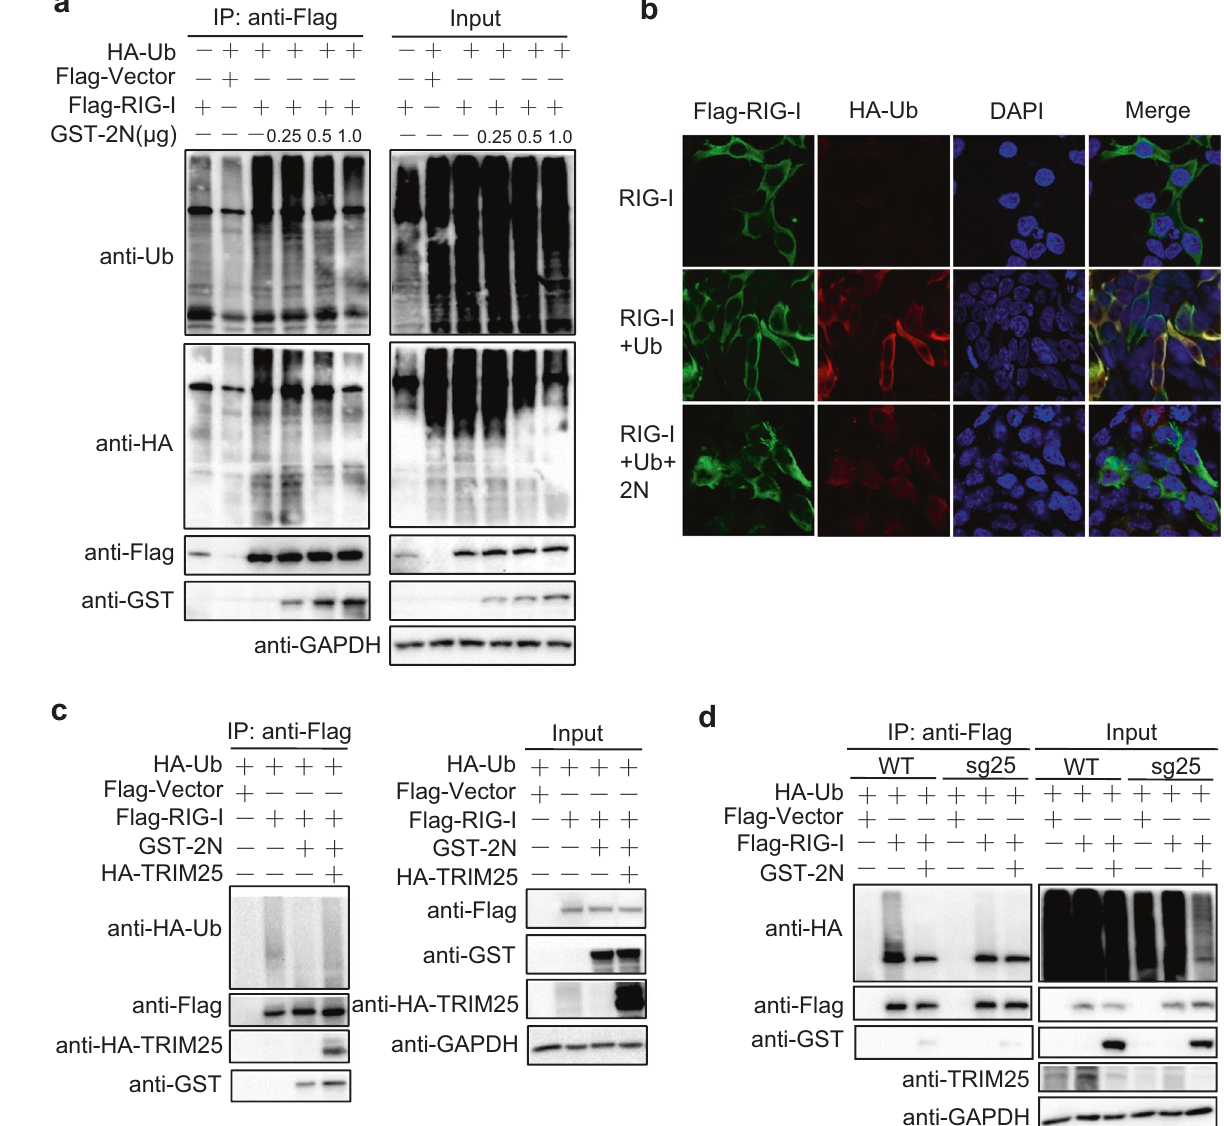
Fig. 6 2N protein inhibits RIG-I ubiquitination through TRIM25. a HEK293T cells in six-well plate were transfected with HA-Ub and Flag-RIG-I plasmids as indicated, together with an increasing GST-SARS-CoV-2 N (GST-2N) plasmid. At 24 hpt, anti-Flag immunoprecipitates were analyzed by immunoblot with anti-Ub, HA, Flag, and GST antibodies. b HEK293T cells in 24-well plate were transfected with Flag-RIG-I, or Flag- RIG-I and HA-Ub, or Flag-RIG-I, HA-Ub, and 0.25 μ g GST-2N plasmids. At 24 hpt, the cells were subjected to immuno fl uorescence with anti-Flag and HA antibodies. c HEK293T cells in six-well plate were transfected with the plasmids as indicated and 1 μ g 2N plasmid, anti-Flag immunoprecipitates were analyzed by immunoblot. d sg25 and WT cells in six-well plate were transfected with the indicated plasmids and 1 μ g 2N plasmid, anti-Flag immunoprecipitates were analyzed by